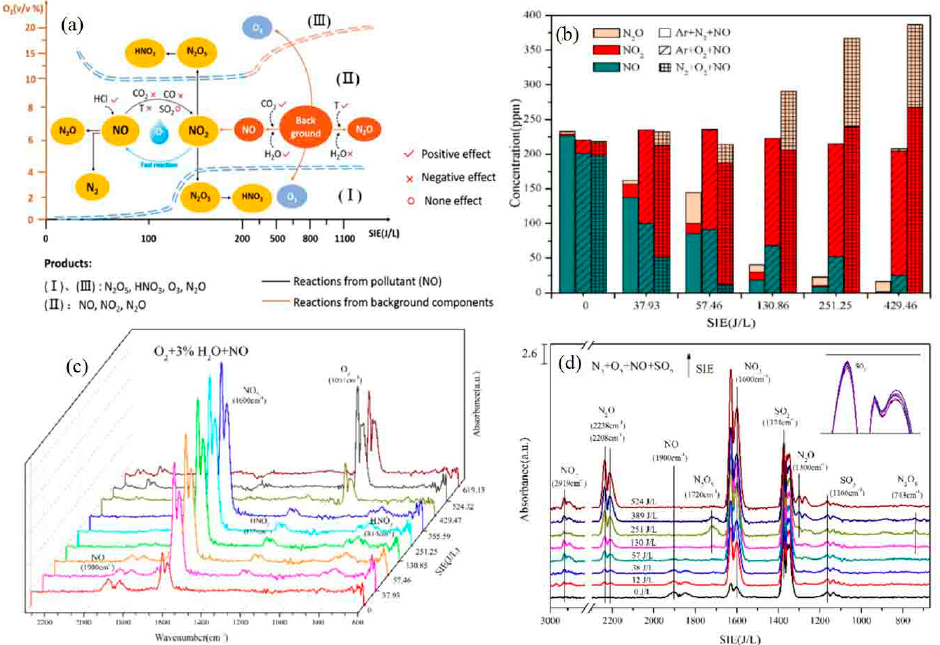
Figure 15. ( a ) Reaction pathway and mechanism of nonthermal plasma for NO removal, ( b ) effect of plasma treatment under different atmospheres, and ( c , d ) effect of H 2 O and SO 2 on nonthermal plasma removal of NO x [241]. Reproduced from Ref. [241], Copyright 2019, Elsevier.